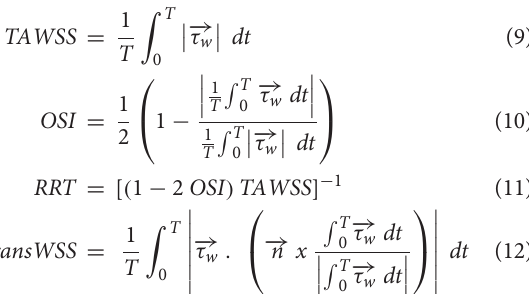
TABLE 3 | Outlet flow percentages for each individual case calculated using Murray’s Law [exponential power of 2, Equation (6)]. H1 H2 H3 TS 1 TS 2 TS 3 TS 4 Q RSA 9% 14% 20% 6% 8% 10% 19% Q RCCA 9% 14% 14% 9% Q LCCA Q LSA 9% Q DescAo 66% 51% 41% 45% 68% 63% 48%